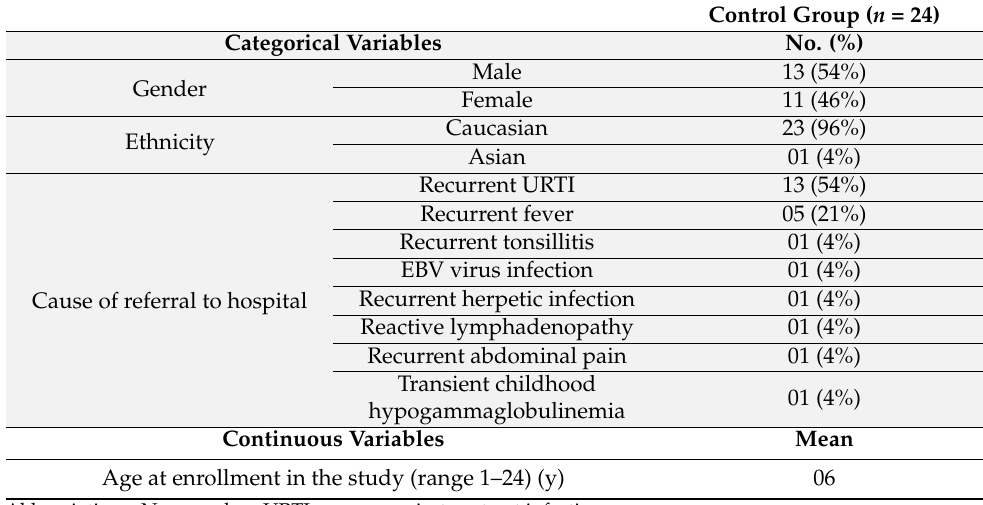
Table 2. Anagraphic and clinical features of the control